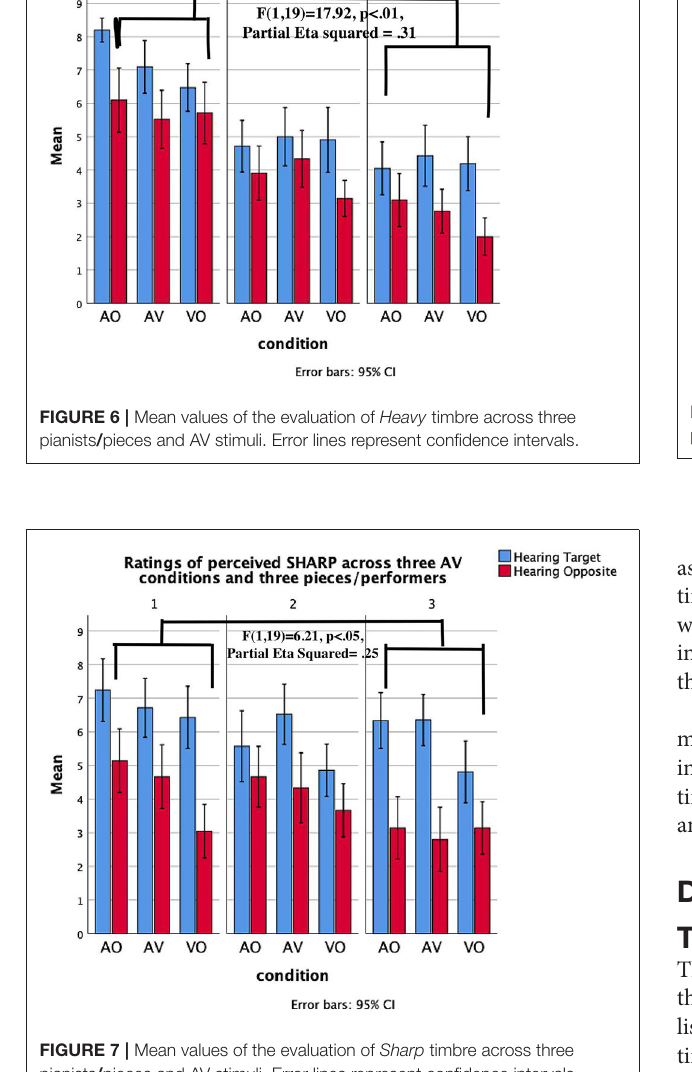
to play velvety timbre. The difference in P3 was little.